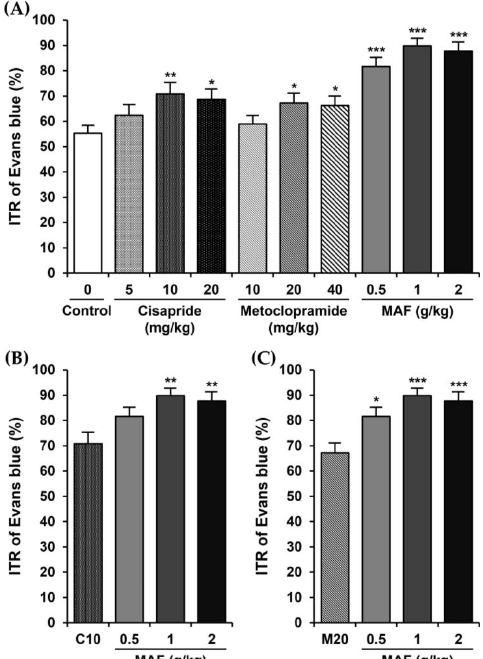
Figure 1. Effects of cisapride, metoclopramide, and MAF on ITR in mice in vivo. The ITR (%) of Evans blue during a 30 min period following oral administration of an Evans blue solution 30 min after pretreatment with each test drug at each dose in mice ( n = 12 for each bar). Data were evaluated by one-way analysis of variance, followed by a Dunnett’s post hoc test, if appropriate. ( A ) Significant difference (* p < 0.05, ** p < 0.01, and *** p < 0.001) compared with control, ( B ) significant difference (** p < 0.01) compared with C10 (ITR in the cisapride-treated group at a dose of 10 mg/kg), ( C ) sig- nificant difference (* p < 0.05 and *** p < 0.001) compared with M20 (ITR in the metoclopramide- treated group at a dose of 20 mg/kg).